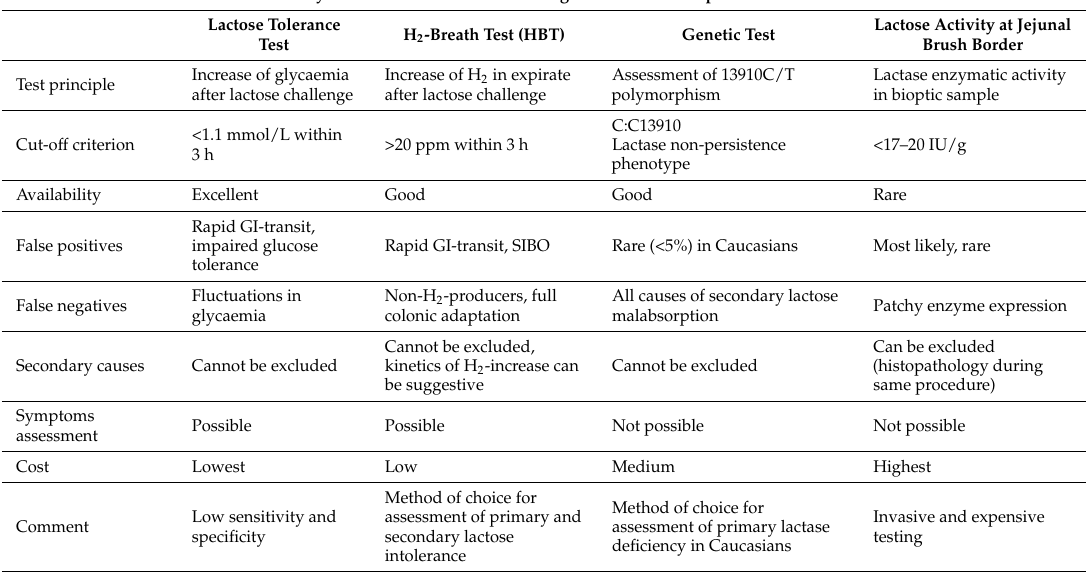
Table 3. Comparison of the characteristics of the tests currently available for assessing lactose malabsorption/intolerance (modified from